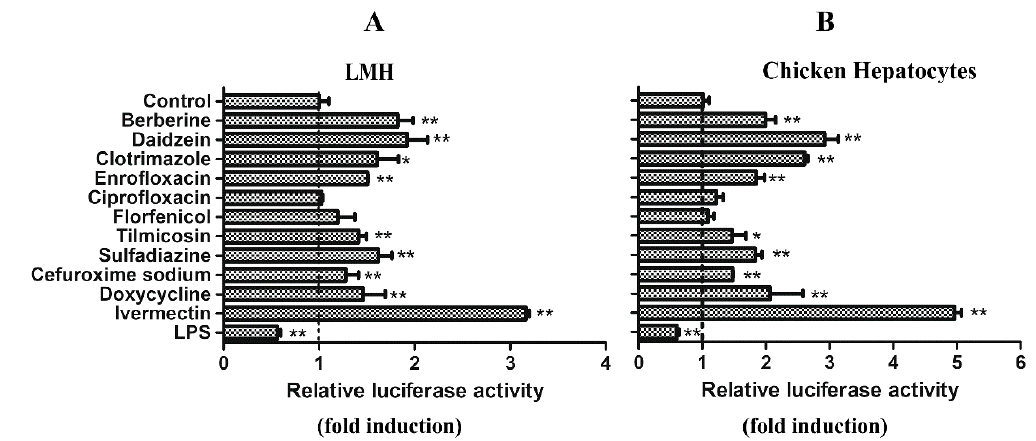
Figure 4. Xenobiotic screening for the chicken Abcg2 gene promoter. The pGL3-D1 constructs were transiently transfected into ( A ) LMH cells and ( B ) chicken hepatocytes. After 12 hours, the cells were treated with test xenobiotics and the control cells received 0.1% DMSO. Following 6 h of treatment, the dual-luciferase activity levels were determined. Data are shown as the percentages of fold activation of the control cells and represent the means of 3 independent experiments. * represents p < 0.05 and ** represents p < 0.01.